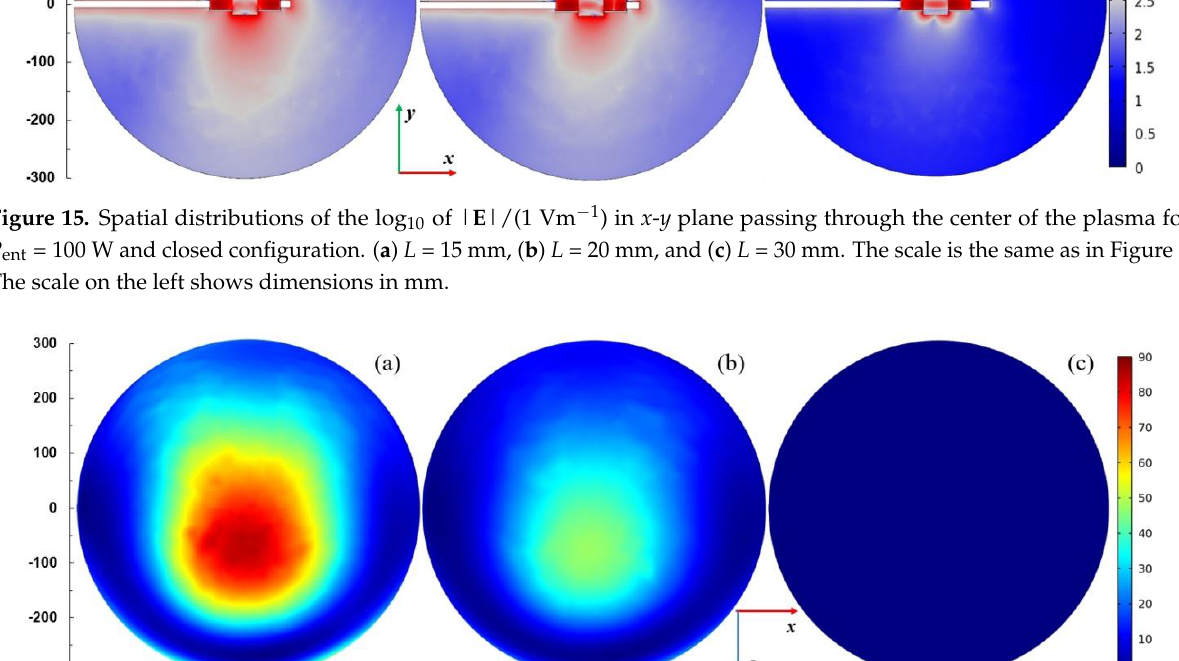
Figure 16. Distributions of the power flux, W, on the top part of the radiation sphere (with radius 300 mm) for P ent = 100 W and closed configuration. ( a ) L = 15 mm, ( b ) L = 20 mm, and ( c ) L = 30 mm. The scale is the same as in Figure 8. The scale on the left shows dimensions in mm.